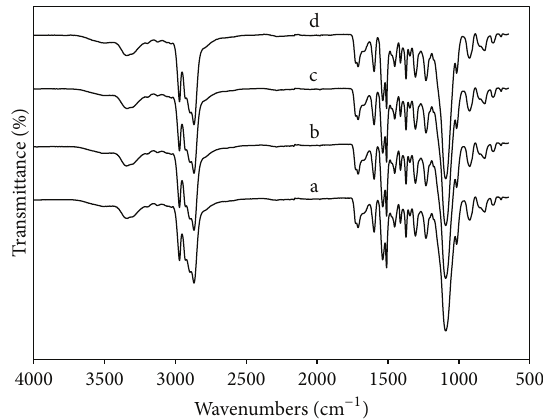
Figure 8: Tensile strength of PU nanocomposite foams and PU bionanocomposite foams with different amounts of OMMT.